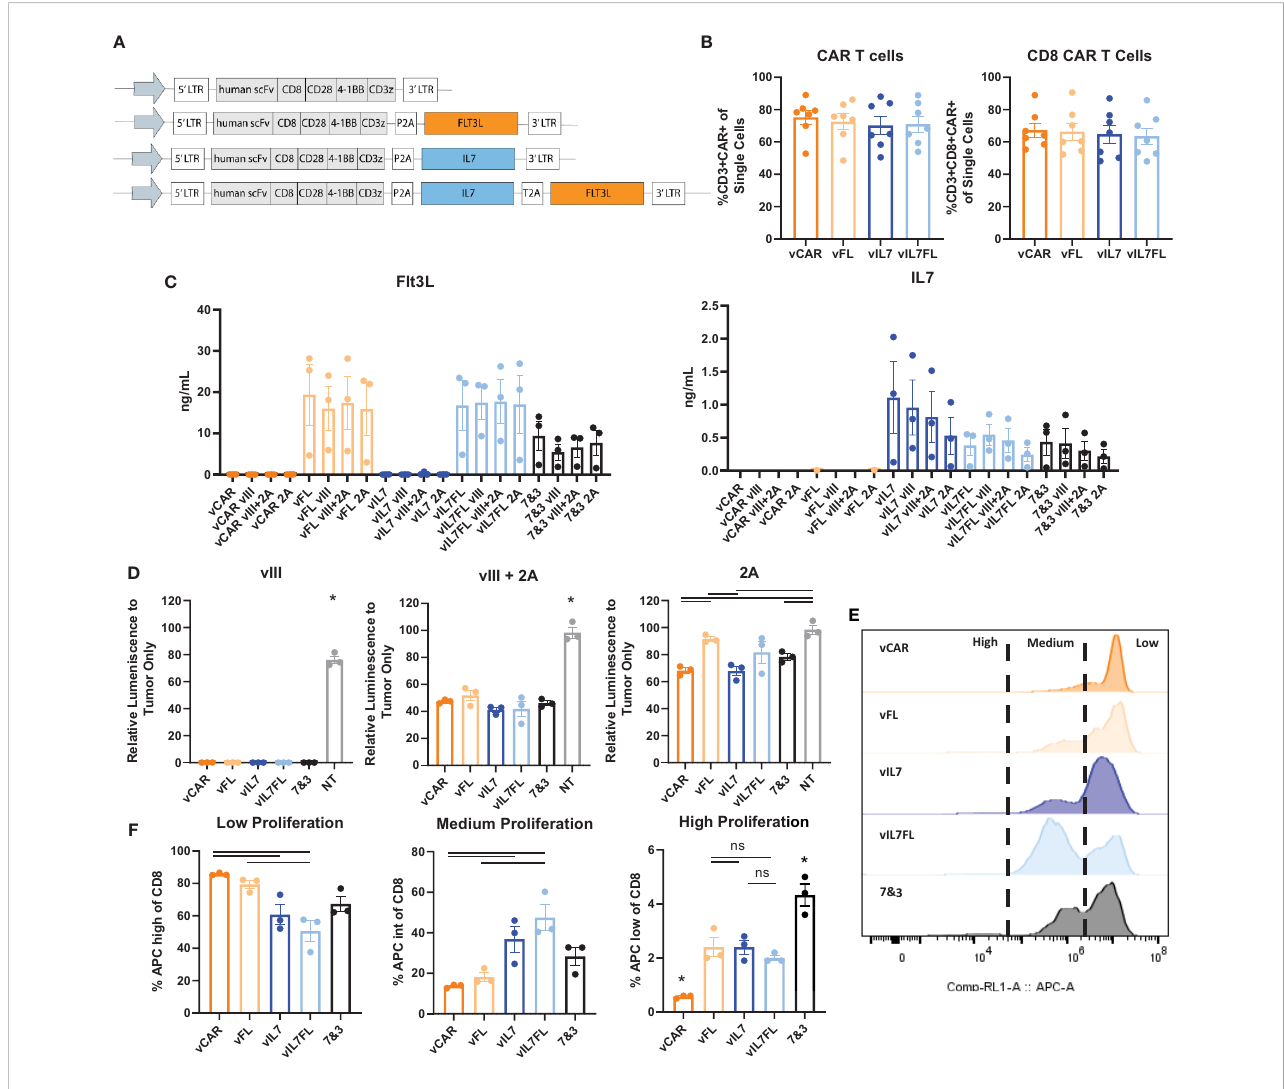
FIGURE 1 Construction and validation of IL7 and/or Flt3L CAR T cells. CAR T cells were made using activated mouse splenocytes and transduced on day 2. (A) Schematic of CAR T cell plasmids. (B) Flow cytometry of day 4 CAR T cells. Cells were stained with CD3, CD8, and a tetrameric peptide recognizing the CAR. (C) CAR T cells were cultured alone or co-cultured with tumor cells (vIII, vIII+2A, or 2A) with an effector:target (E:T) ratio of 10:1. 24 hours later the supernatant was collected for a Flt3L or IL7 ELISA. (D) CAR T cells were co-cultured with tumor cells with an E:T ratio of 10:1. 72 hours later bioluminescence signal was measured using a plate reader and normalized to tumor only signal. NT = non-transduced. (E) Cell proliferation of CAR T cells co-cultured with vIII tumor cells. CAR T cells were stained with CellTrace Far Red and plated at an E:T ratio of 1:1. After three days, cells were gated on live CD8 T cells and analyzed for APC expression indicating proliferation using a fl ow cytometer. Representative histograms of cell proliferation de fi ne low, medium, and high proliferation. (F) Quanti fi cation of cell proliferation from three replicates in one biological sample mean and SEM plotted. For all other experiments, each data point represents a biological replicate with mean and SEM plotted. Statistical analysis was conducted within each tumor group using a one-way ANOVA with a Tukey ’ s multiple comparison test. * = denotes signi fi cance compared to all other groups. ns, not signi fi